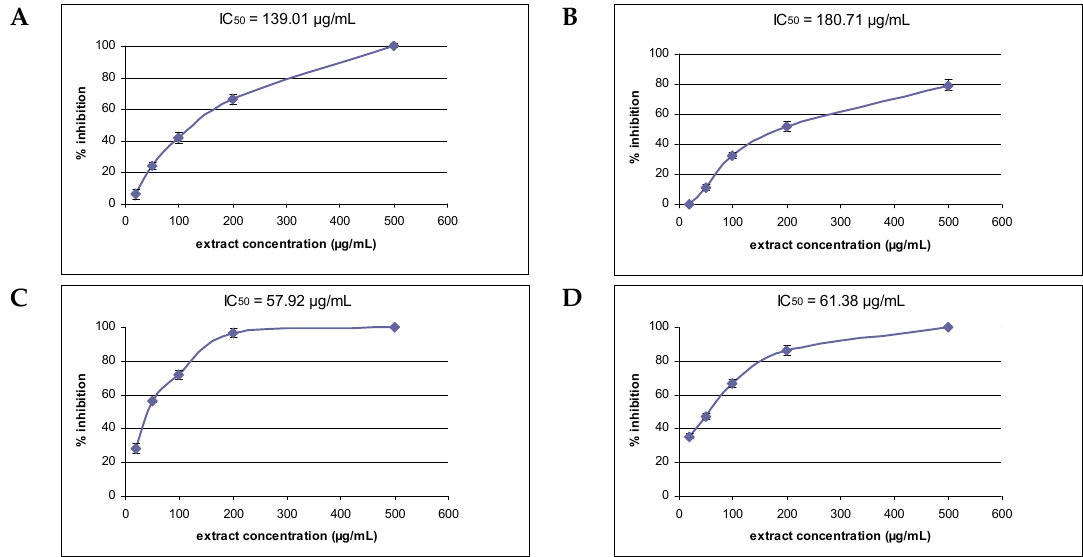
Figure 1. The inhibitory effect on advanced glycation end-products (AGE) formation of Scutellaria altissima shoot ( A ) and root ( B ) extracts and S. alpina shoot ( C ) and root ( D ) extracts at different concentrations. The results are mean values ± SE. IC 50 , the concentration ( μ g/mL) required to reduce fluorescent AGE formation by 50% ( n = 4–5).